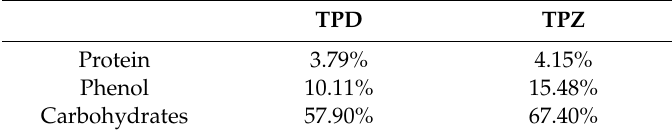
Table 1. The content determination of crude polysaccharide from Tubers